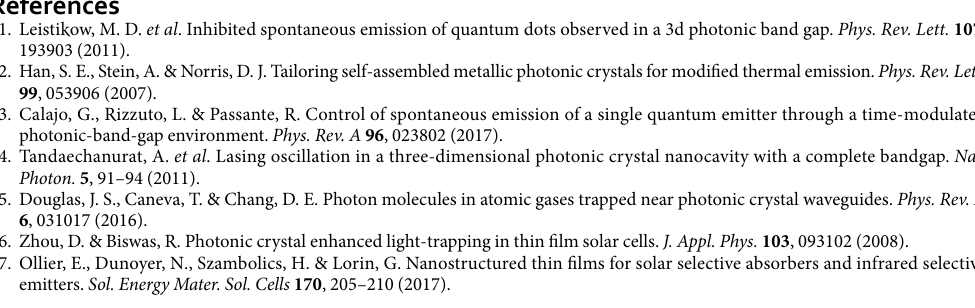
profile to shift due to the Bragg’s rule.